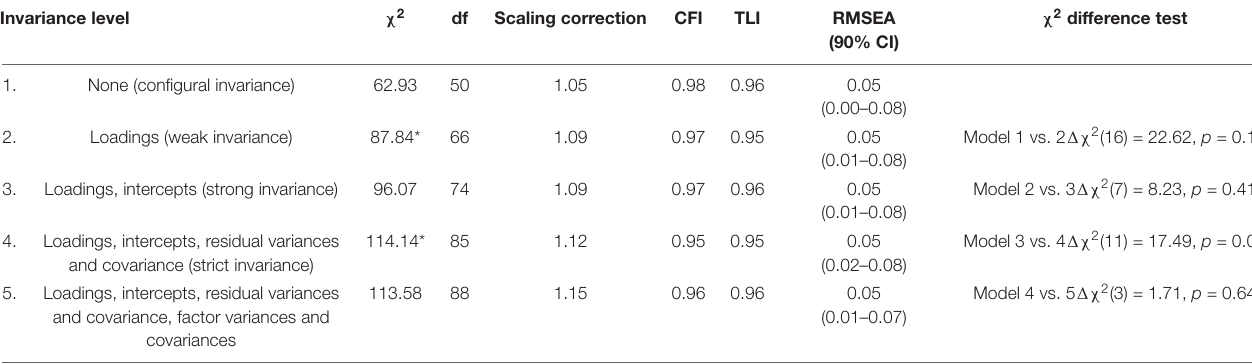
TABLE 5 | Fit index values from the multiple group tests of measurement invariance across data sets 1 and 2, representing professionals from real estate services ( n = 138) and healthcare ( n = 102), respectively. Invariance level χ 2 df